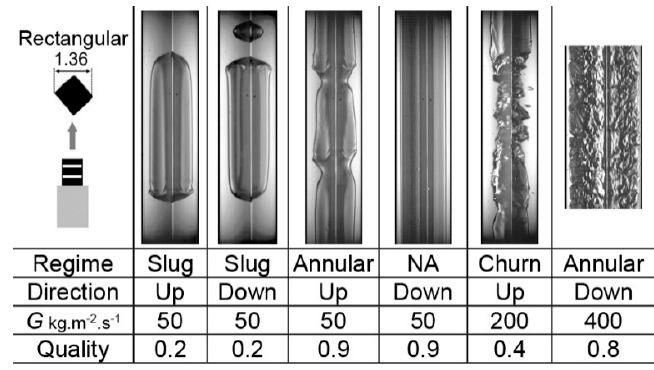
Figure 11. Rectangular channel visualization with pylex glass [14].